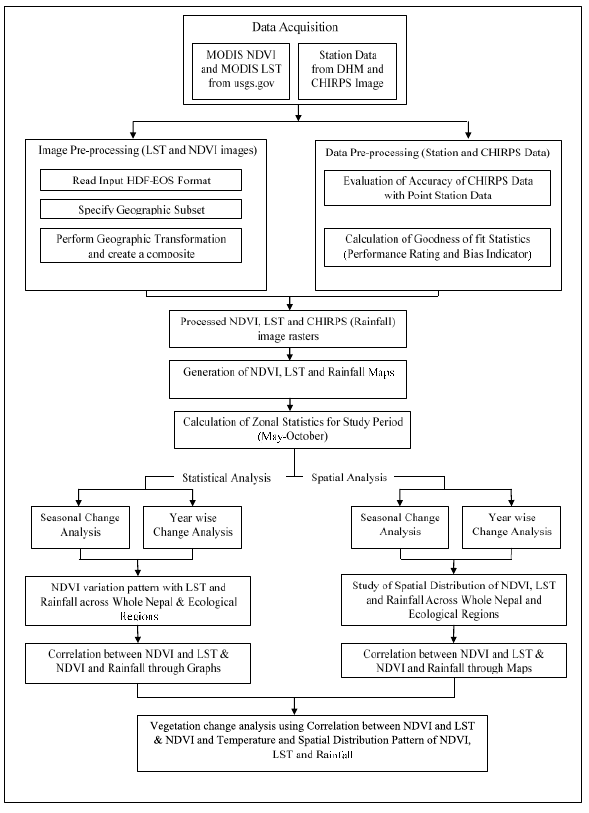
Figure 2. Workflow of the